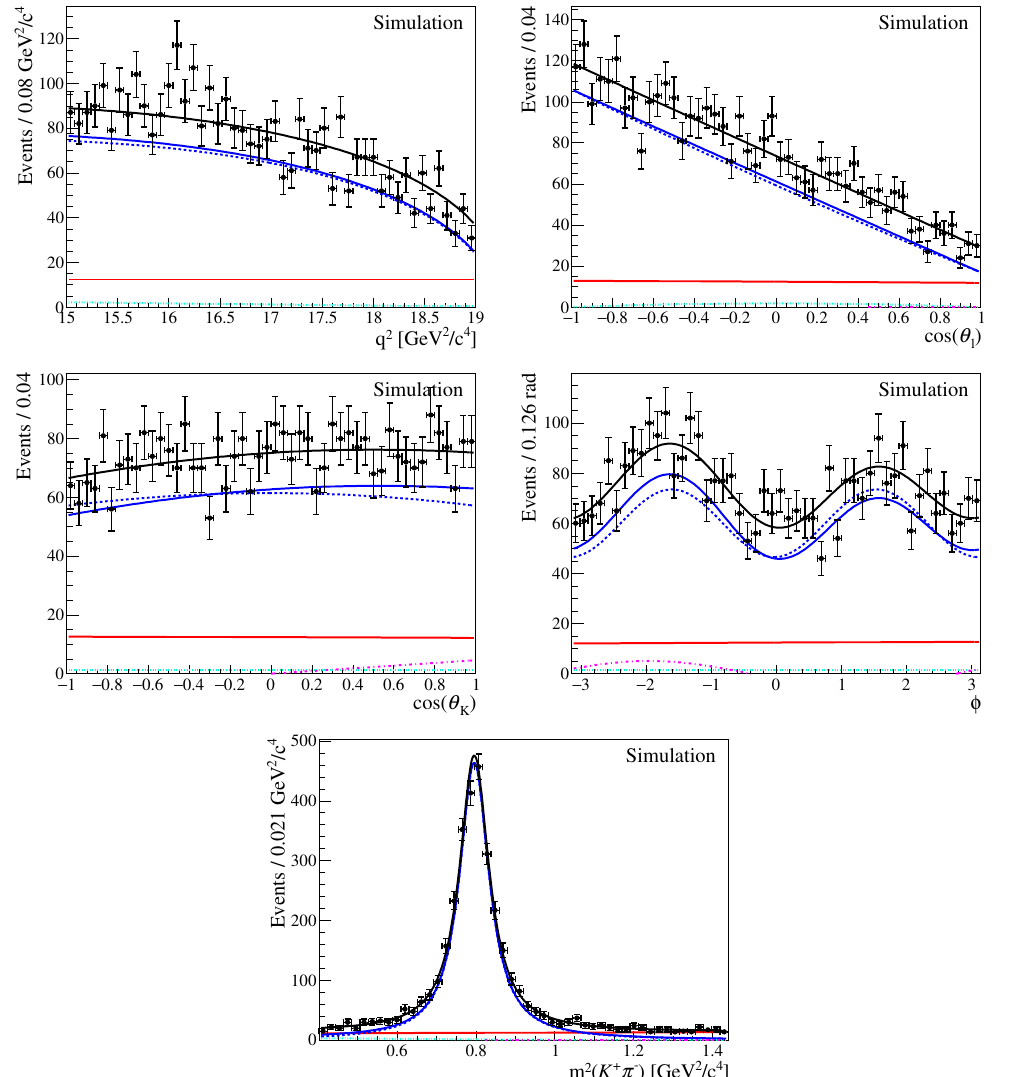
Figure 5. Results from the (cid:12)t of a single pseudoexperiment varying the Wilson coe(cid:14)cients Re( C 7 ) and Re( C 9 ). Simulated events are overlaid with projections of the (cid:12)tted PDF on q 2 , the three decay angles cos (cid:18) l , cos (cid:18) K and (cid:30) and m 2 in the q 2 range 15 : 0 < q 2 < 19 : 0 GeV 2 =c 4 . The simulated events K(cid:25) and projections are shown for the signal region (cid:6) 50 MeV =c 2 around the B 0 mass to enhance the signal fraction. The black solid line denotes the full PDF, the blue solid line the signal component. The blue dashed line gives the P-wave and the teal dotted line the S-wave part. The magenta dash-dotted line (cid:12)nally gives the P-wave/S-wave interference and the red line the background con- tribution. We note again that the q 2 distribution in the high q 2 region is only shown for illustration, as it is not used in the direct (cid:12)t